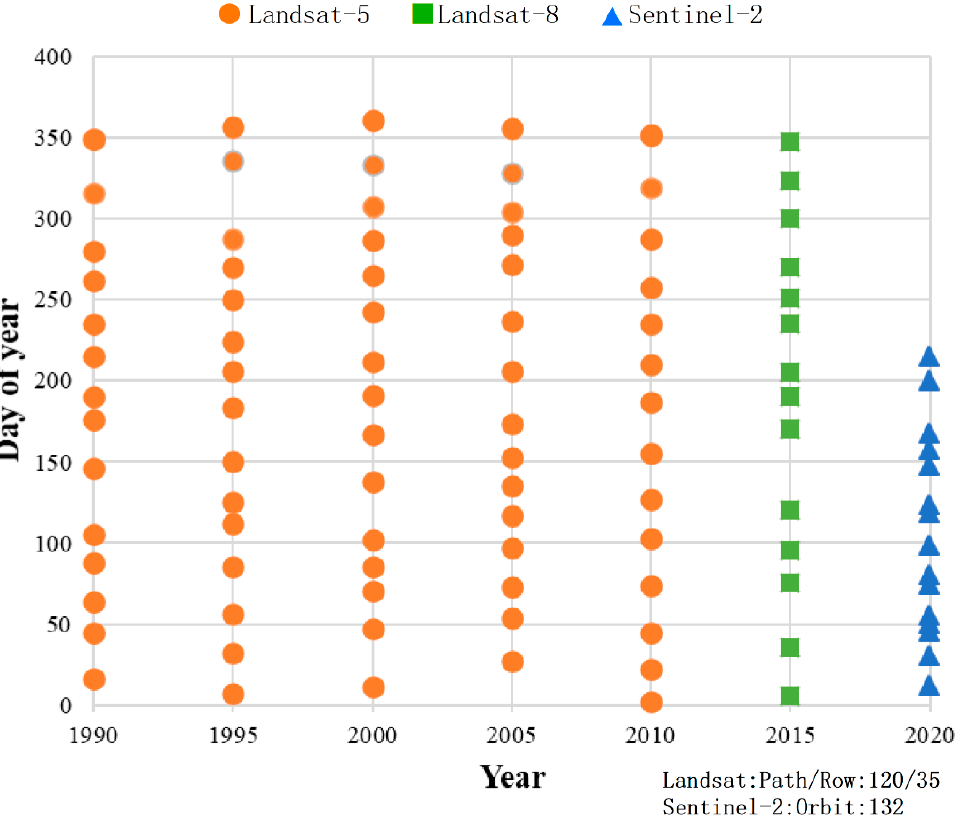
Figure 2. Acquisition time of remote sensing images. The atmospheric correction needs to be performed on the acquired images to obtain true surface reflectance data. Sentinel-2 (L1C) images were processed by the Sen2Cor- 2.8.0 algorithm [26] published by the ESA and converted into L2A images, and then the images were resampled to 10 m resolution through SNAP software and converted into ENVI standard format. The Sen2Cor algorithm was a plug-in released by the ESA for atmospheric correction of Sentinel series images. The core of the algorithm was the atmospheric radiation transmission model libRadtran [27]. This model was suitable for various atmospheric conditions, including the radiation, irradiance, and photochemical flux of the sun and part of Earth’s spectrum. The Landsat image was corrected by the FLAASH atmospheric correction model in ENVI [28], and finally, the image to be classified in the Jiaozhou Bay area was obtained by cropping.